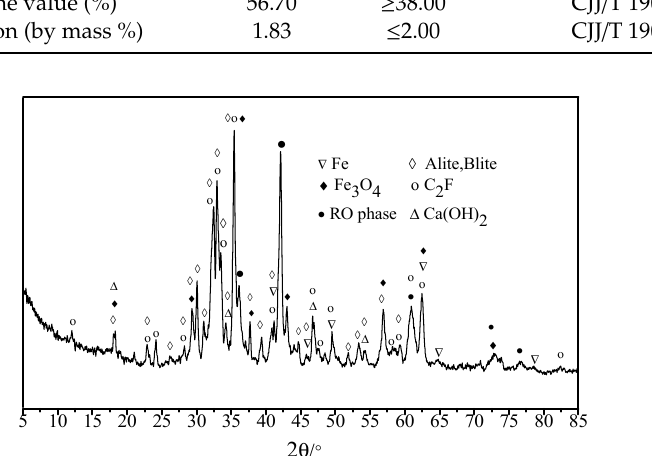
Table 1. Chemical composition of metallurgical steel slag (wt.%).